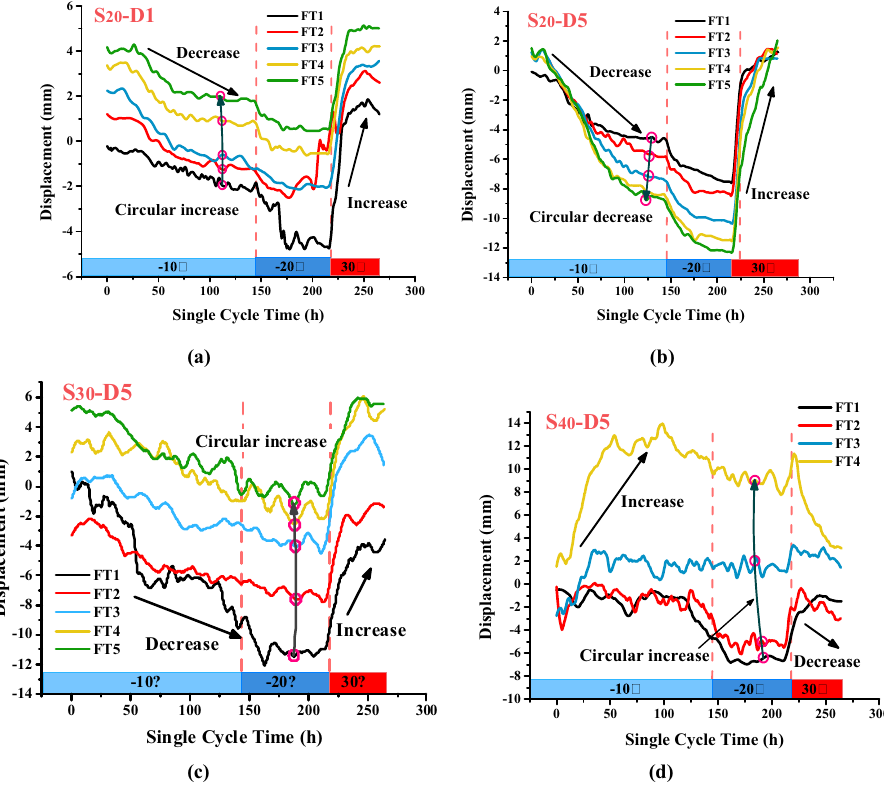
Figure 5. Slope displacement during freeze–thaw cycling (( a ) bottom of the S 20 slope; ( b ) top of the S 20 slope; ( c ) top of the S 30 slope; ( d ) top of the S 40